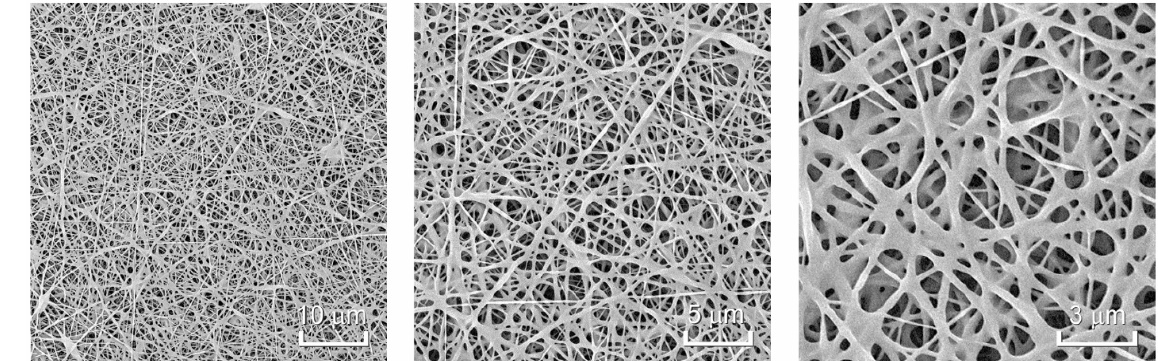
Figure 2. SEM micrographs of electrospun n -60/40 nanofibers (only n -60/40_20 mat is shown for brevity).